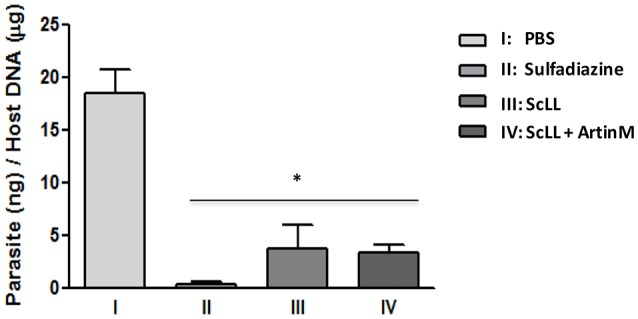
Parasite burden in the brain tissues from treated mice after 30 days of infection with T. gondii ME-29 strain and analyzed by quantitative real-time PCR. Statistical significances were calculated by comparison the parasitic DNA values among the treated and non-treated groups of mice. Statistical test was performed using One-way ANOVA and Tukey's multiple comparison post-test. *Indicates significant differences (P < 0.05).